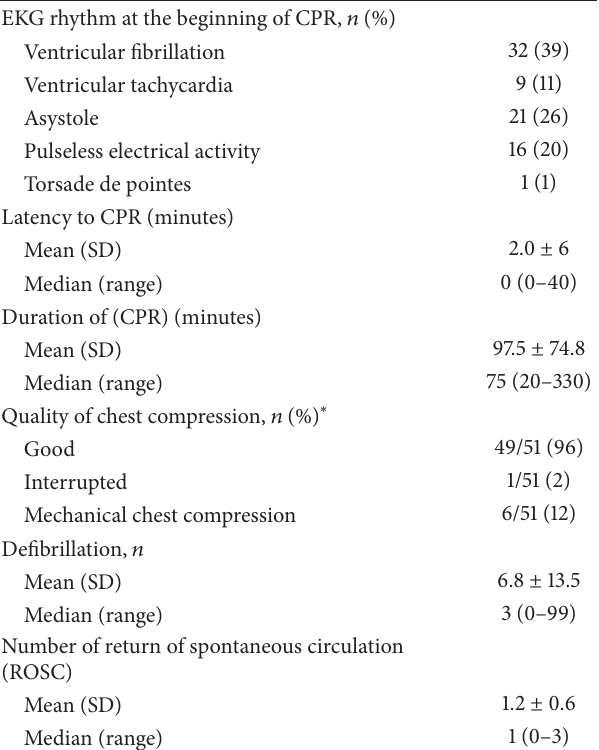
Table 2: Characteristics of the cardiac arrests. Table 3: Use of adjunct therapy.